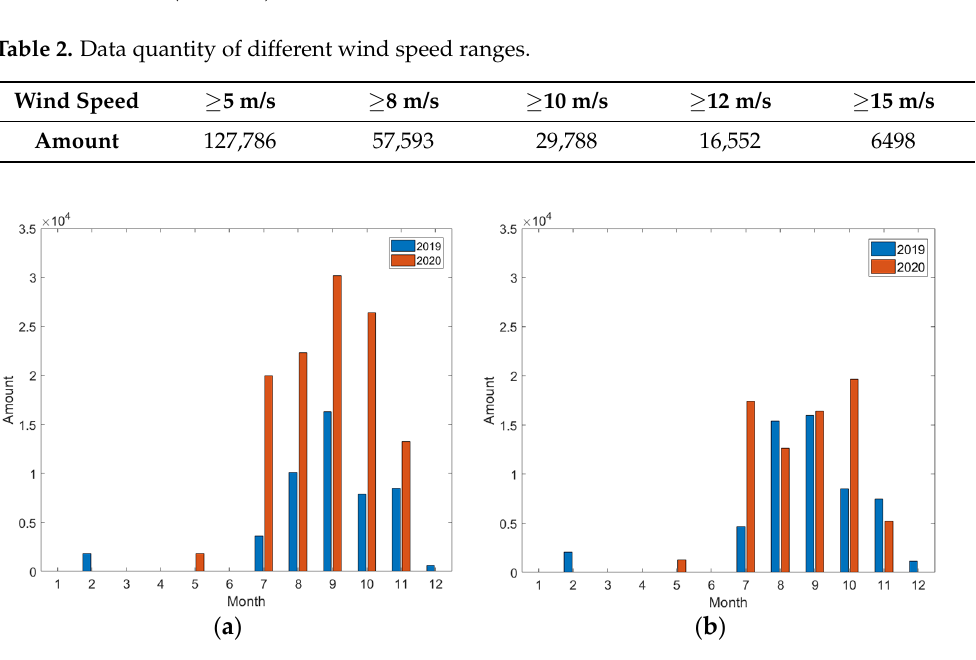
Figure 8. Quantitative distribution of Full DDM data in different months before ( a ) and after data preprocessing ( b